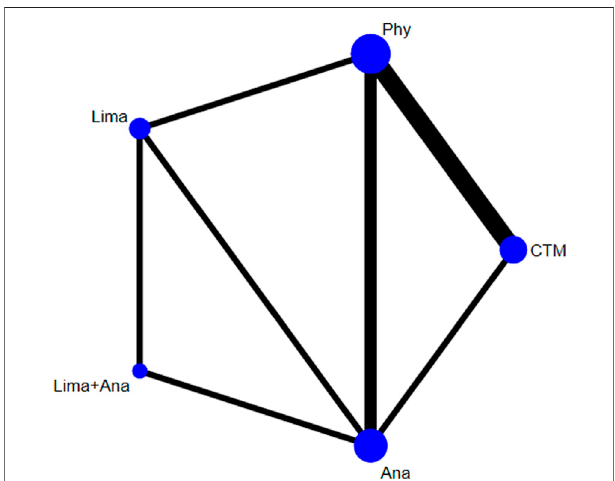
FIGURE 4 | Network plot for included studies on ODI.